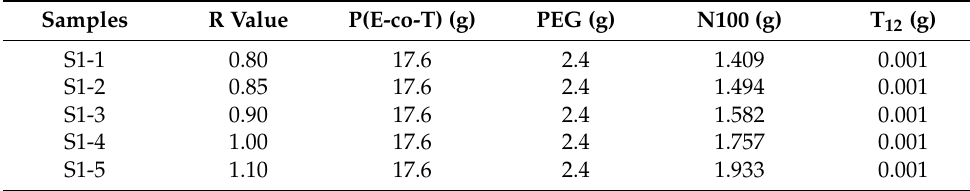
Table 1. Formulation composition of elastomers with different R values.